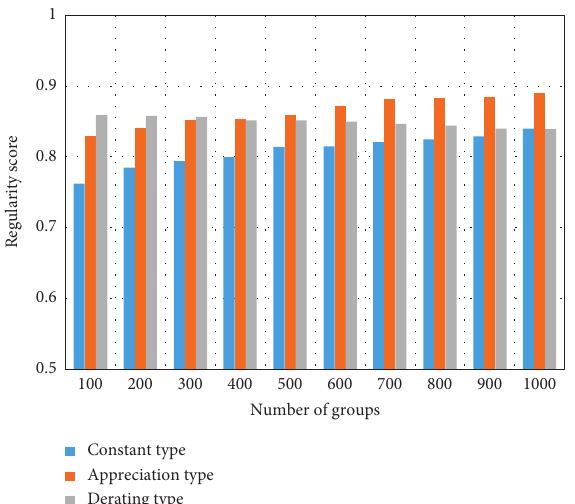
Figure 5: Experimental results of the number of nodes in different hidden